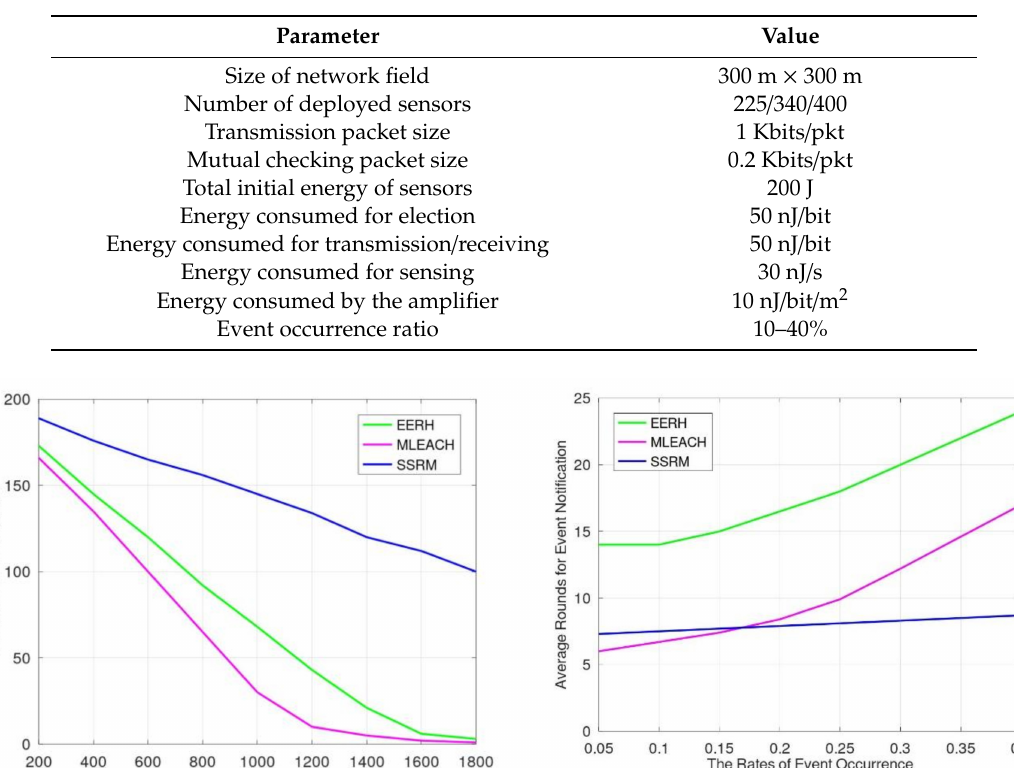
Table 2. Simulation parameters.